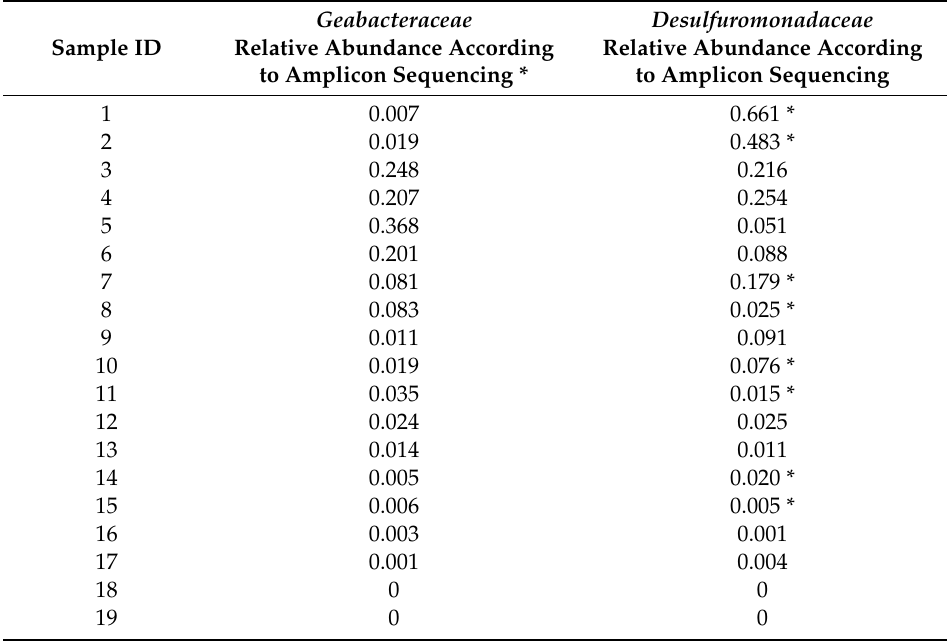
Table 2. The samples used for testing the different primer sets for their specificity to the Desulfuromonadaceae and Geabacteraceae groups with their relative abundance according to amplicon sequencing results. * Indicates the sample had a positive PCR product for the specific 16S ‐ Desulfuromonadaceae primer set [29].